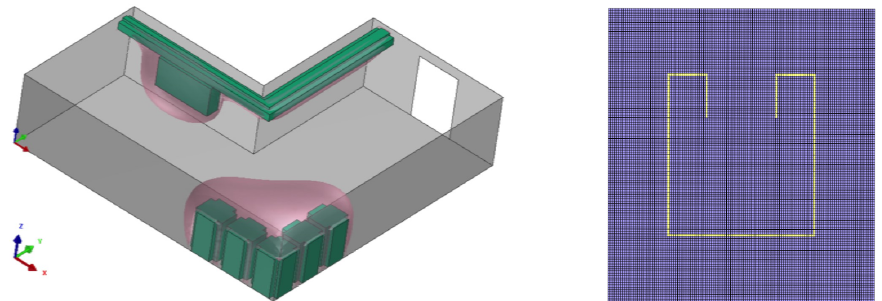
Figure 1. Complex and real environments for navigation: ( left ) L-shaped corridor in a plant; ( right ) bug trap planning